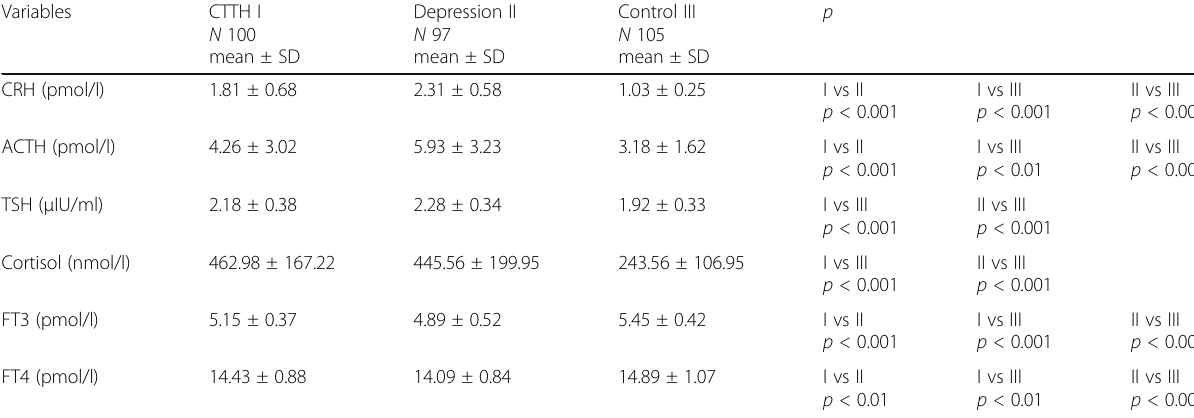
Table 3 Serum levels of hormones in studied subjects Variables